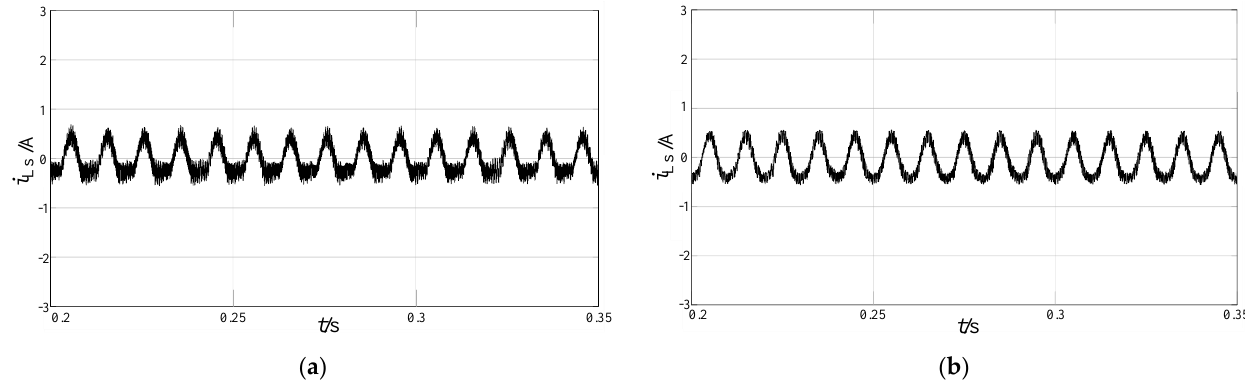
Figure 16. Power decoupling circuit inductor current: ( a ) conventional double closed - loop control; ( b ) model current prediction control.